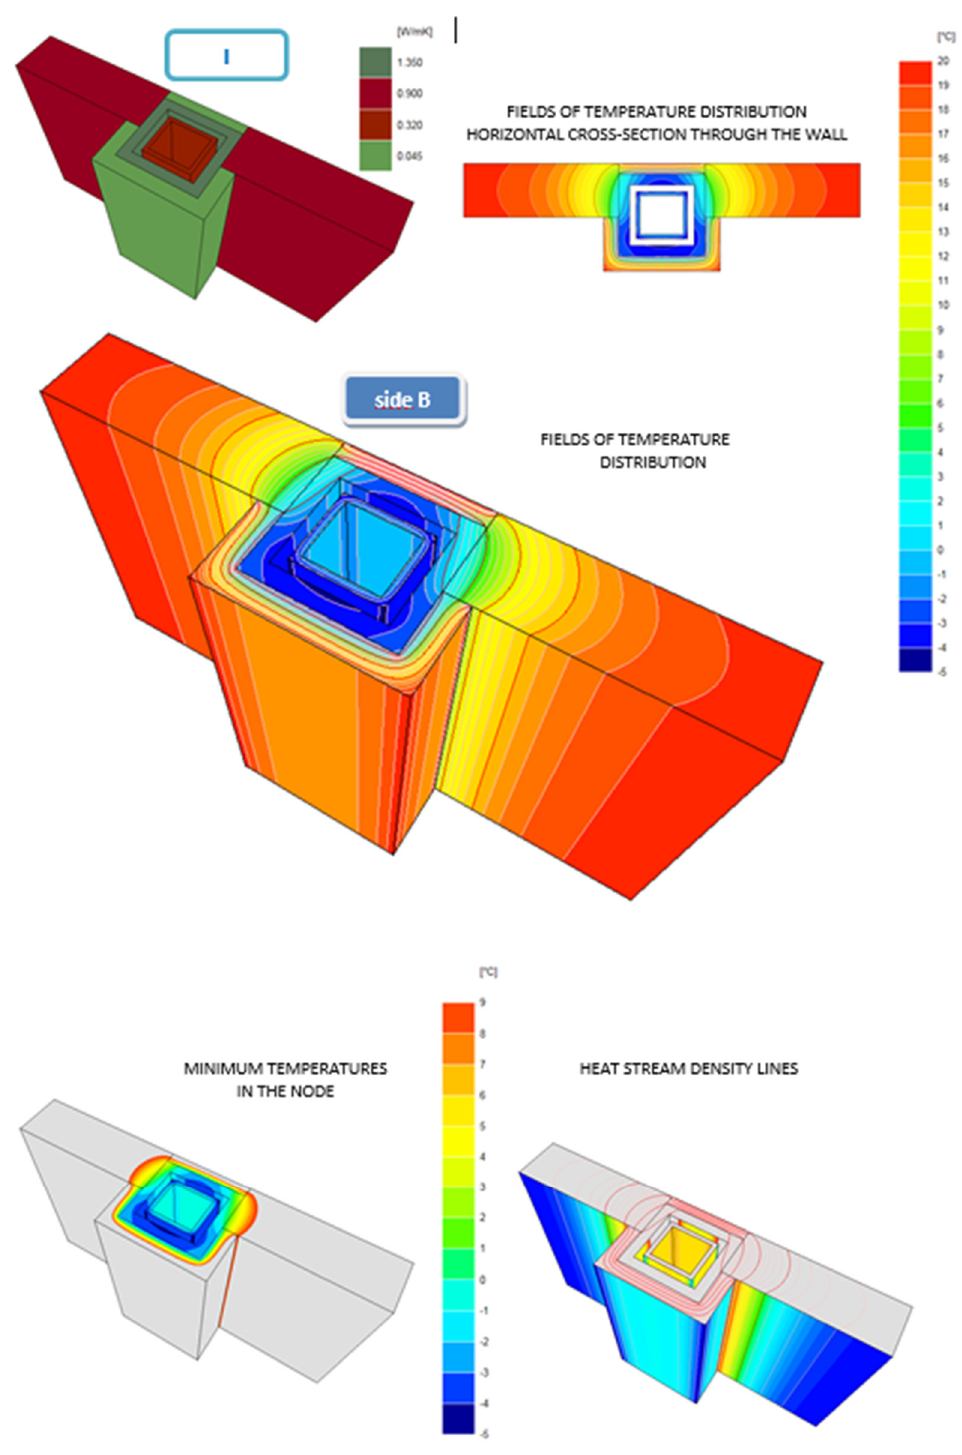
Figure A9. Scheme I: isotherm field distribution, minimum surface temperature, and heat flux distribution.